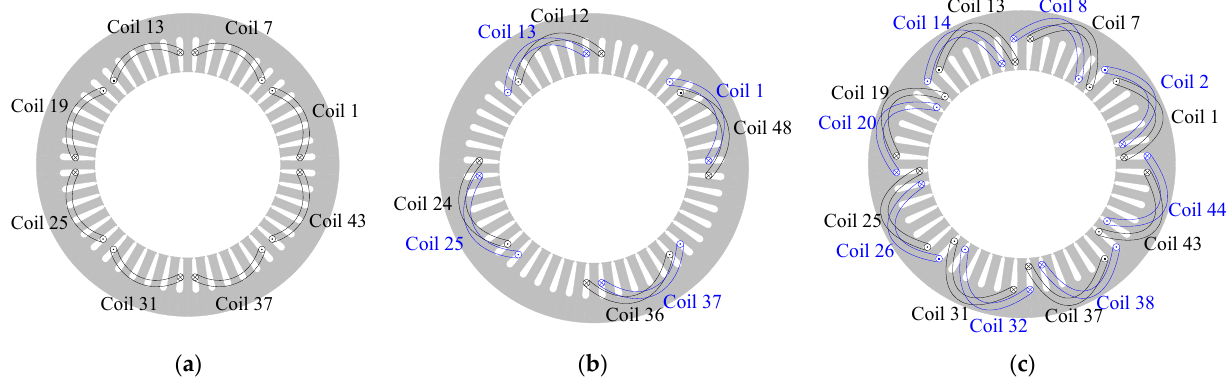
Figure 3. Winding layouts of Phase A in ORG machine and Phases A1 and A2 in DTP machines: ( a ) ORG; ( b ) DTP-SF; ( c ) DTP-DS.